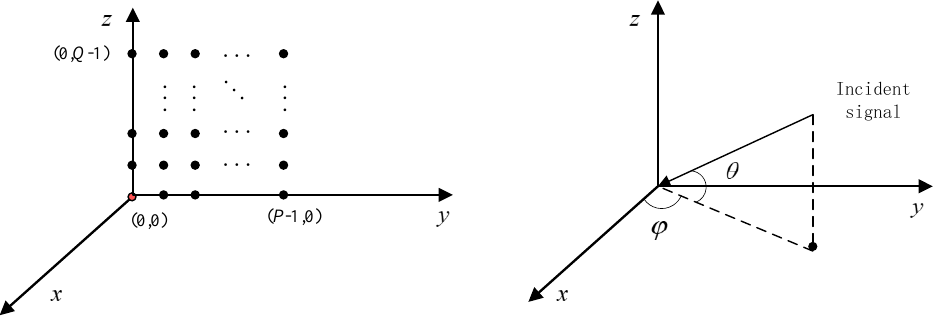
Figure 1. Structure of two-dimensional planar rectangular array antenna.